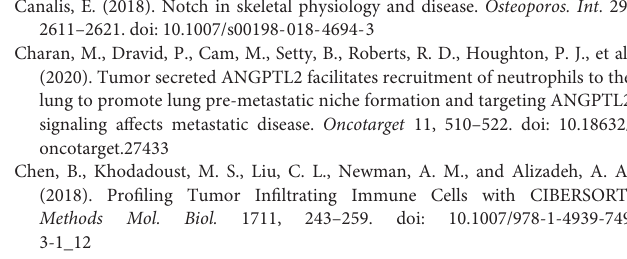
Supplementary Figure 1 | Prognostic nomogram for OS